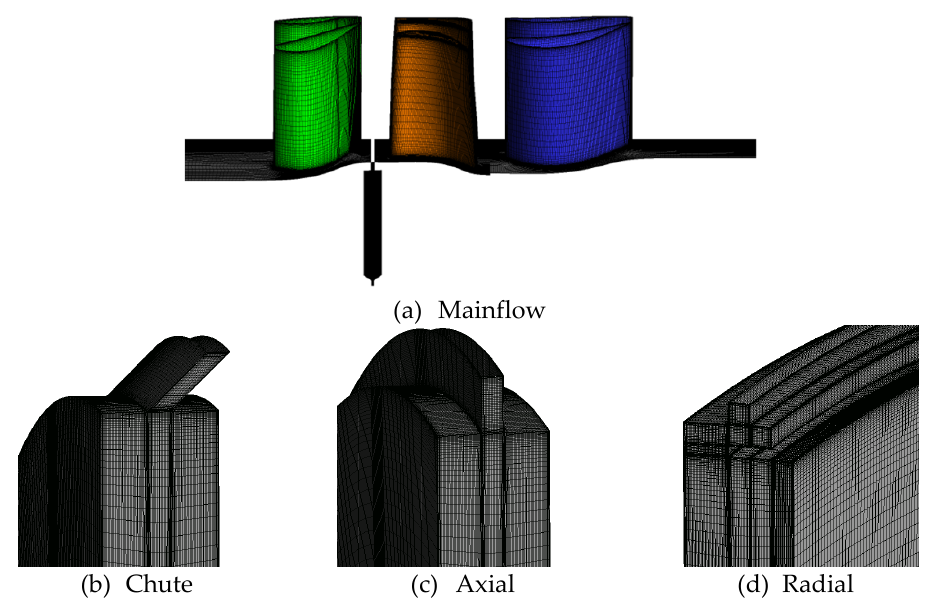
Figure 2. Computation mesh of a 1.5-stage turbine.